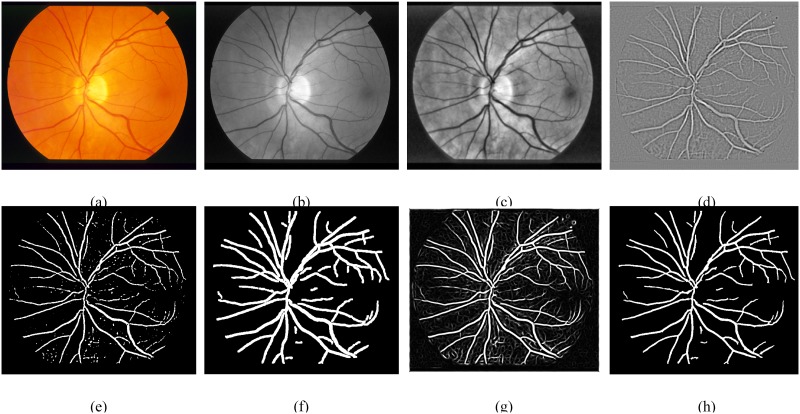
Visual presentation of the proposed system major processing stages.(a) Input RGB photograph from STARE database (b) Green channel (c) CLAHE applied result (d) Difference image (e) Otsu threshold resultant image (f) Postprocessed dilated image (g) Frangi filter enhanced image (h) Final image using AND Operation.